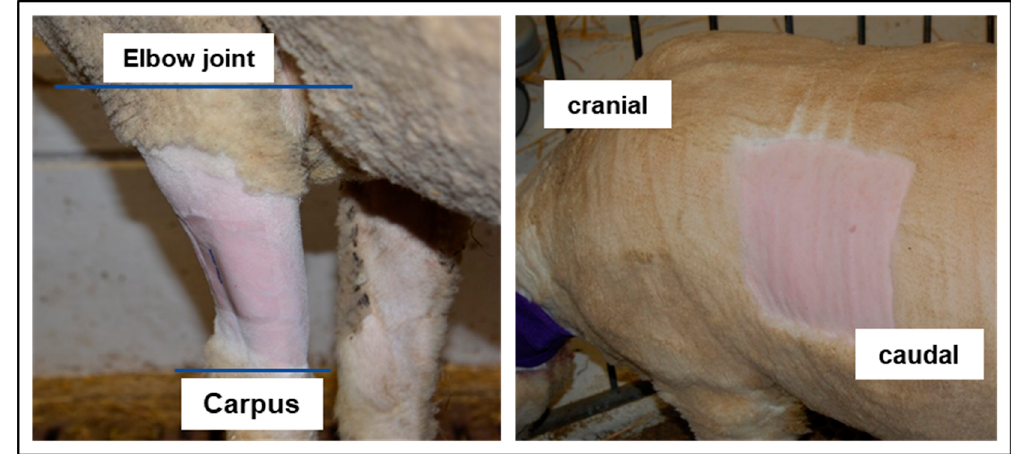
Figure 2. Transdermal fentanyl patch location—left picture: foreleg, right picture: thorax .